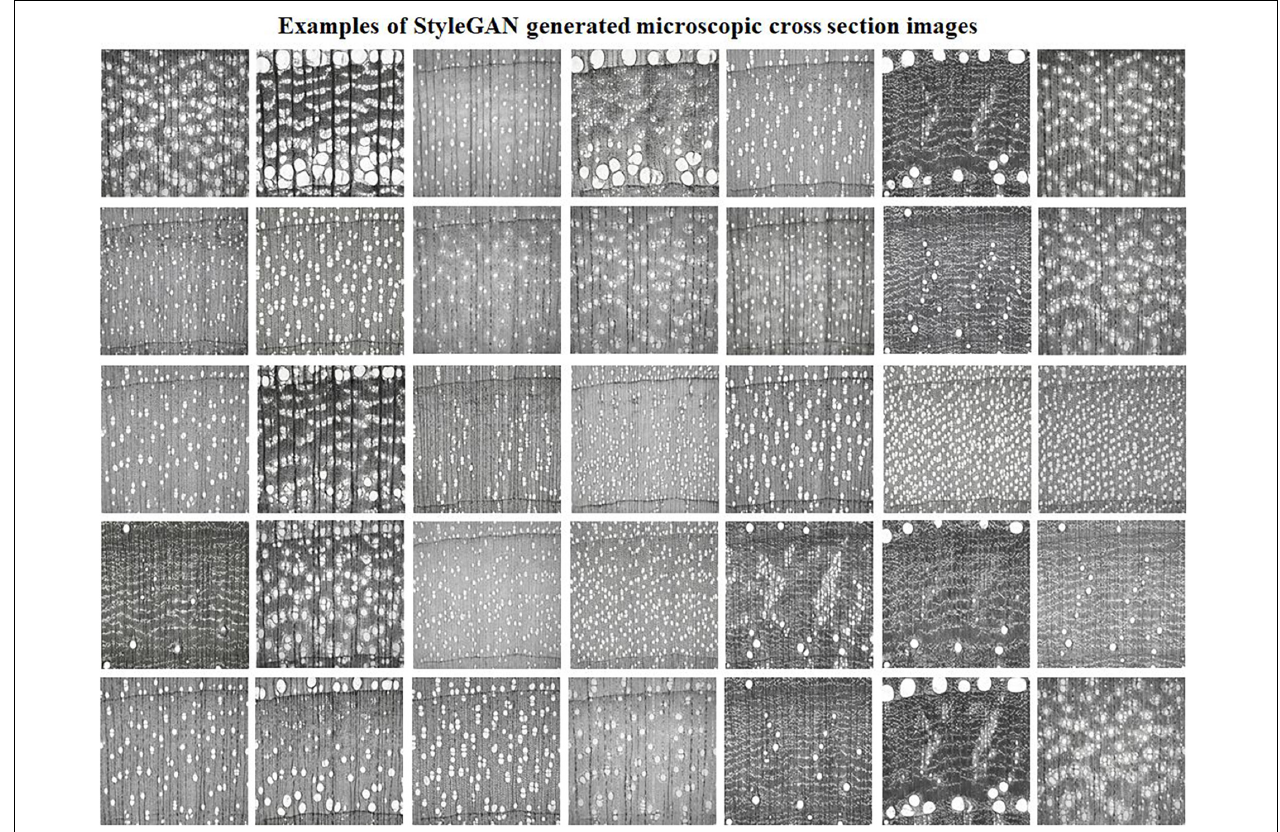
FIGURE 3 | Examples of synthetic cross-section images of hardwood species produced by the